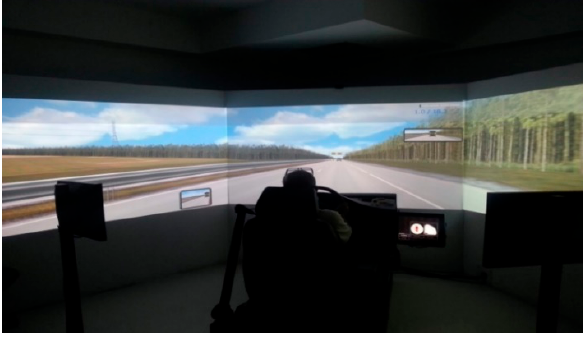
Figure 1. The driving simulator’s environment.